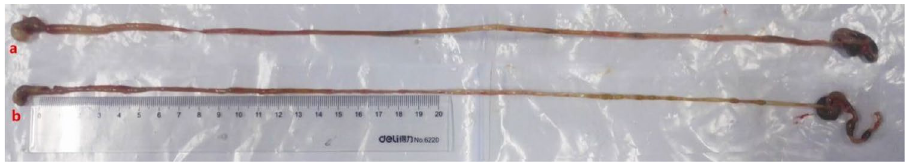
Figure 4. At 540 min after gavage, the nutritive semi-solid paste was completely emptied from the stomach and small intestine in mice. ( a ) and ( b ) are GIT images from mice at 540 min and 570 min after gavage. Whole nutritional semi-solid paste in the stomach and small intestine entered the cecum.